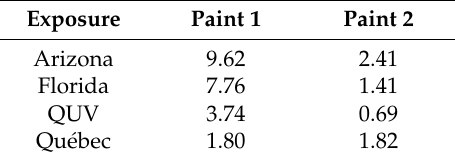
Table 5. Maximum variation of the ∆ E CMC parameter for each paint and exposure site.